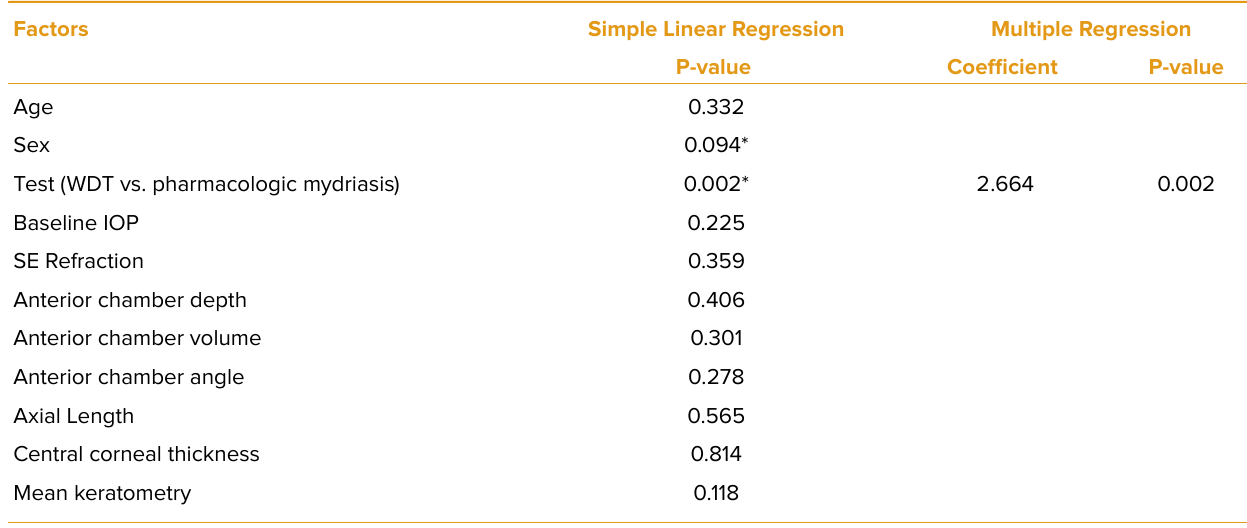
Table 3. Regression analysis of possible factors affecting IOP change after provocative tests of water-drinking test and pharma- cologic mydriasis in patients with primary angle closure suspect after laser peripheral iridotomy